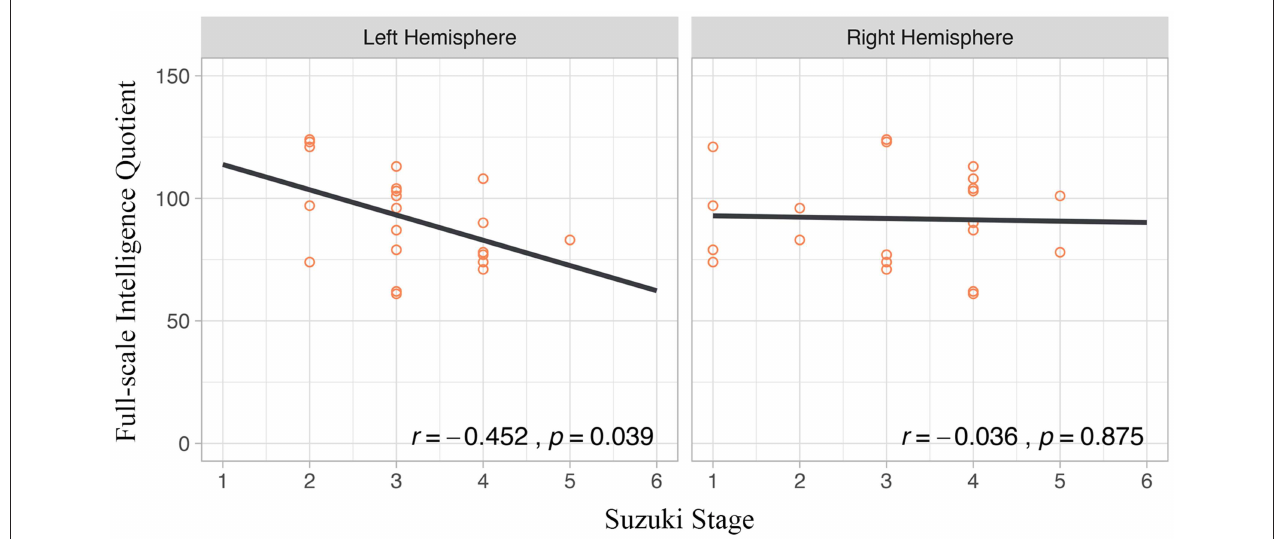
FIGURE 3 | Correlations between Full-scale Intelligence Quotient and Suzuki Stage.